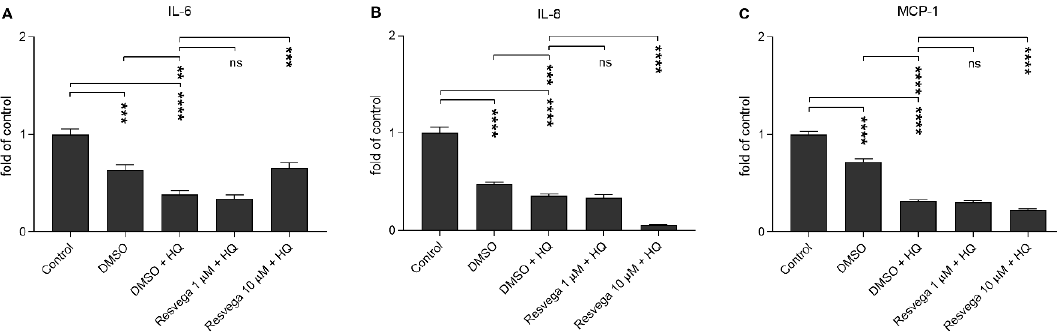
Figure 3. The effect of Resvega (DMSO 0.5% v / v ) to the secretion of inflammatory cytokines IL-6 ( A ), IL-8 ( B ), and MCP-1 ( C ) from hydroquinone (HQ)-exposed RPE cells. The cytokine levels of untreated control cells were set to be 1 and other groups were compared to that. IL-6 concentrations ranged between 1.06–7.33 pg / mL, IL-8 between 2.35–162.25 pg / mL, and MCP-1 between 95.77–1995.88 pg /